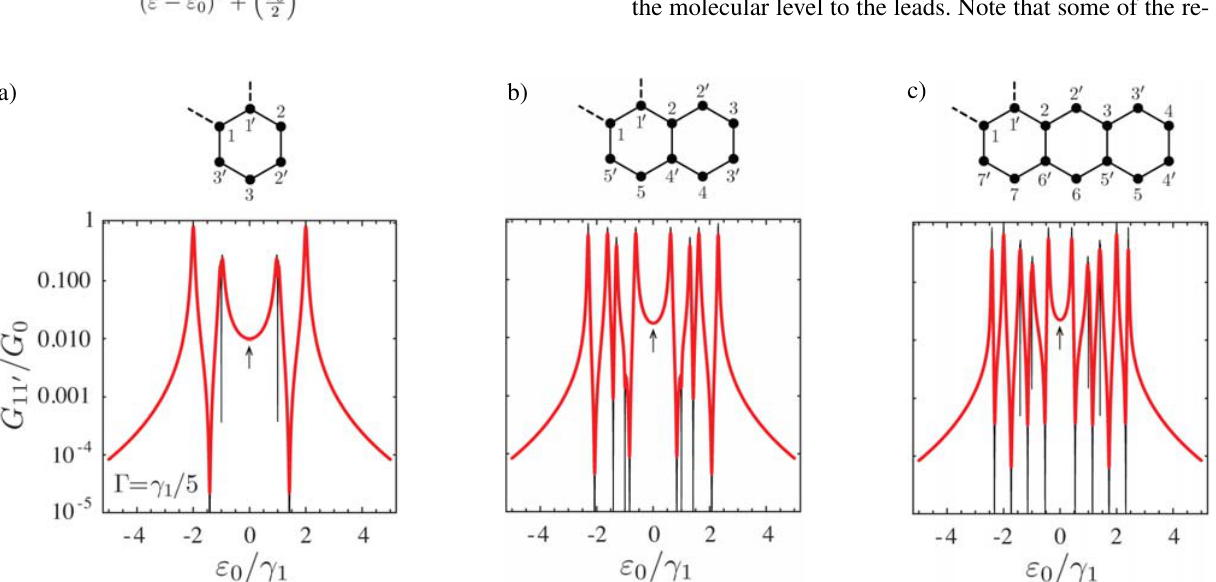
Figure 2. Conductance as a function of top gate voltage of the (a) benzene, (b) naphthalene, and (c) anthracene molecule when one electrode is con- nected to site 1 and the other is connected to site 1’of the molecule, at T = 0 (black lines) and at the room temperature (red lines). The coupling of an electrode to the molecular site is Γ = γ 1 /5 . Arrows indicate the position of the center of the HOMO-LUMO gap.